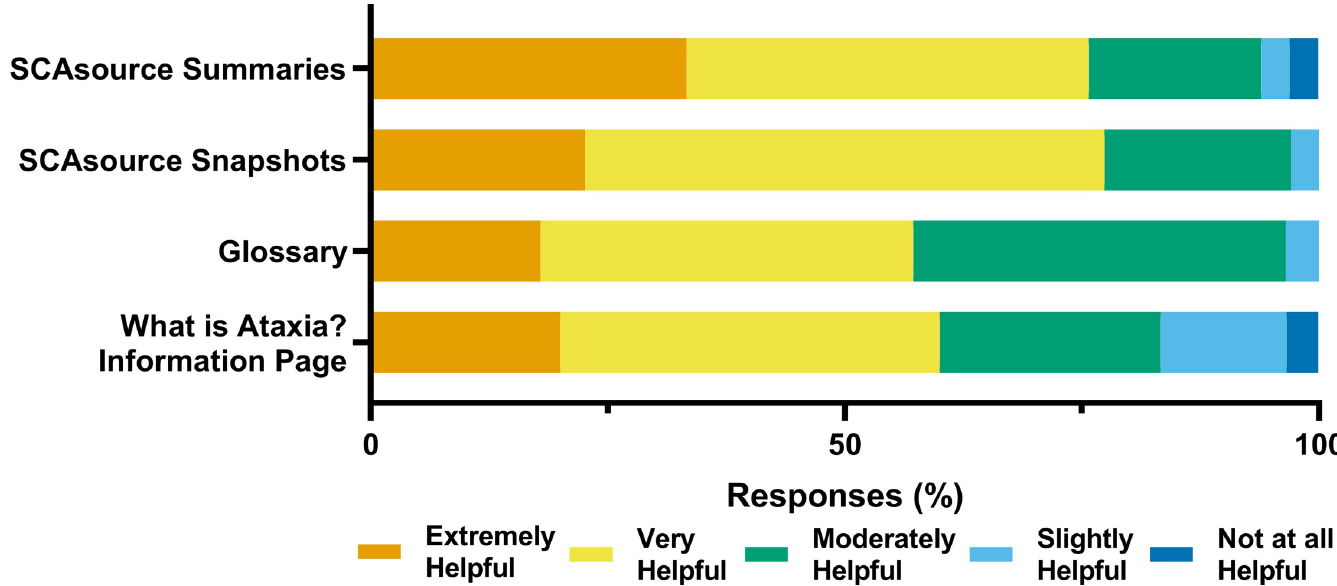
Fig 4. Reader helpfulness ratings of SCAsource content. Respondents were asked to rate the helpfulness of four content types of SCAsource; summaries, snapshots, the glossary, and the “What is Ataxia?” information page. Responses were given with the indicated 5-point Likert-type scale.